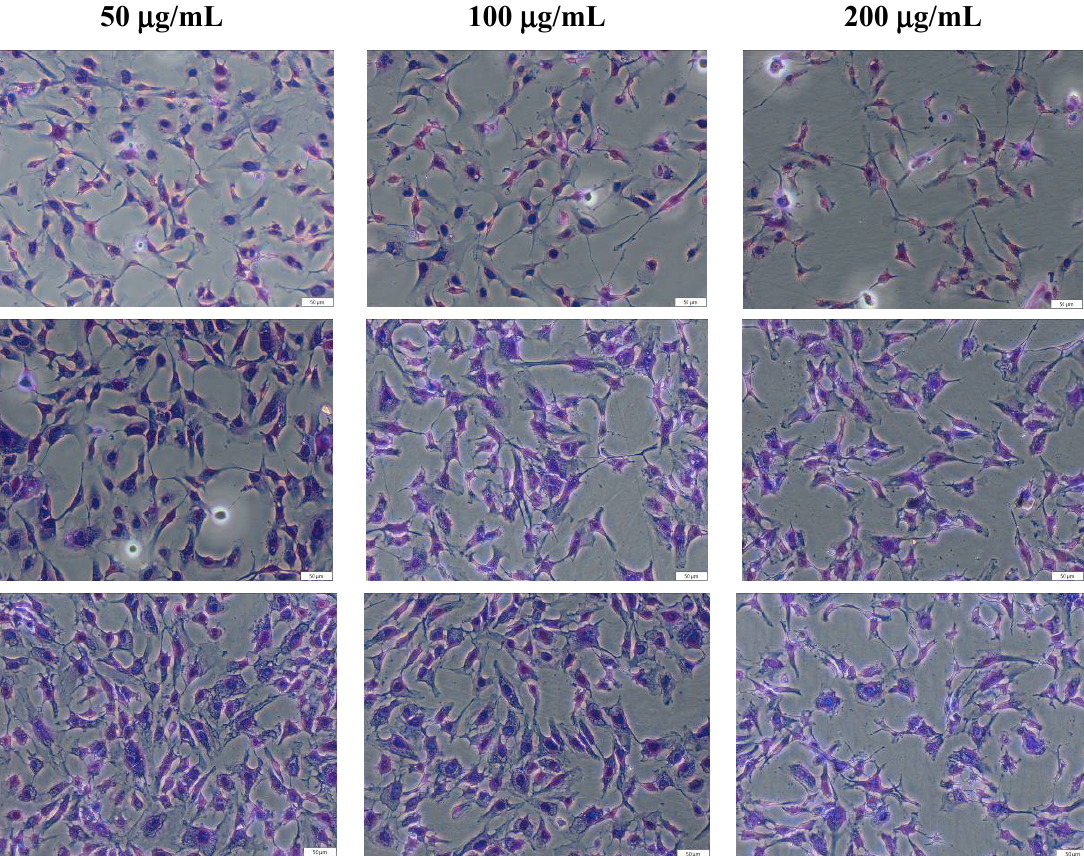
Figure 5. Morphological changes of the cells HMEC-1 before and after treatment with silica nanoparticles (biogenic) at concentration of 0–200 μ g/mL and after three periods of incubation. The scale bar corresponds to 50 μ m.